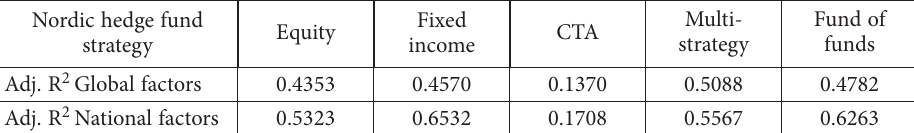
Table 8. Nordic hedge fund panel data global and national model comparison Nordic hedge fund